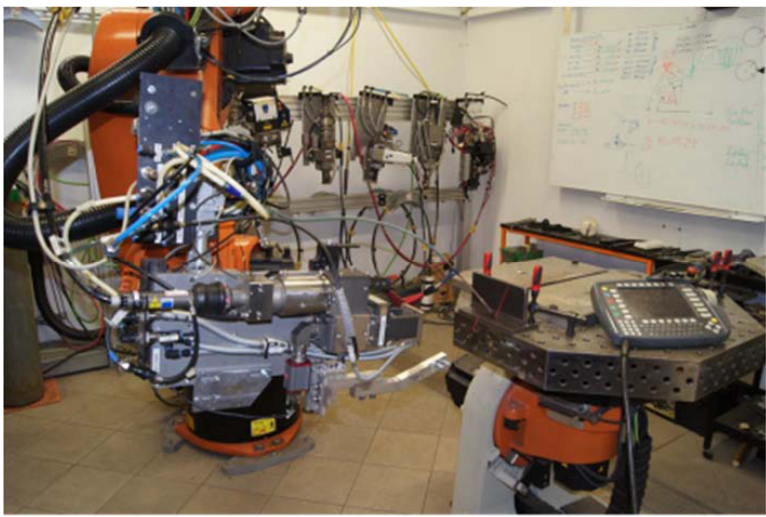
Figure 3. Station for the laser welding of T ‐ joints.